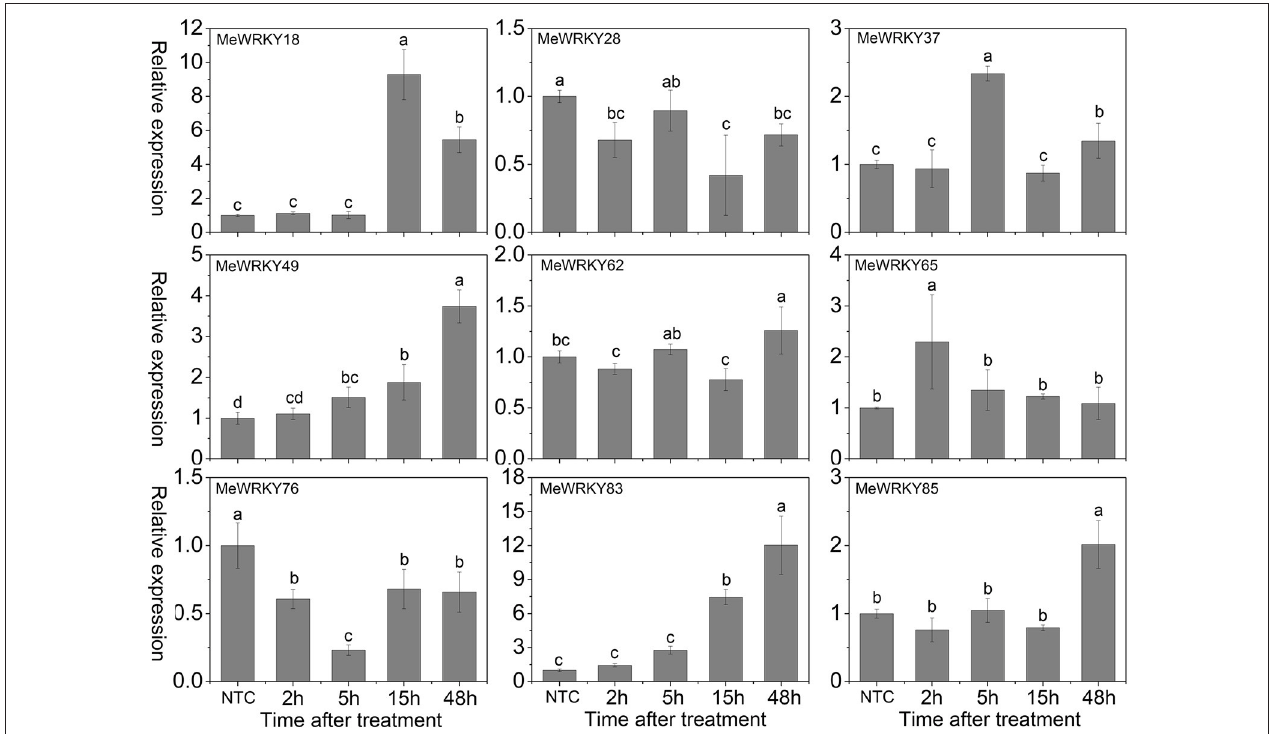
FIGURE 8 | Expression profiles of MeWRKY genes in leaves under cold treatment. The relative expression levels of MeWRKY genes in each treated time point were compared with that in each time point at normal conditions. NTC (no treatment control) at each time point was normalized as “1.” Data are means ± SE calculated from three biological replicates. Values with the same letter were not significantly different according to Duncan’s multiple range tests ( P < 0.05 , n = 3 ).